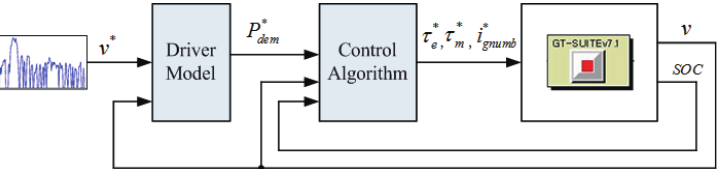
Figure 9. Simulation test bench with the GT-Suite simulator.